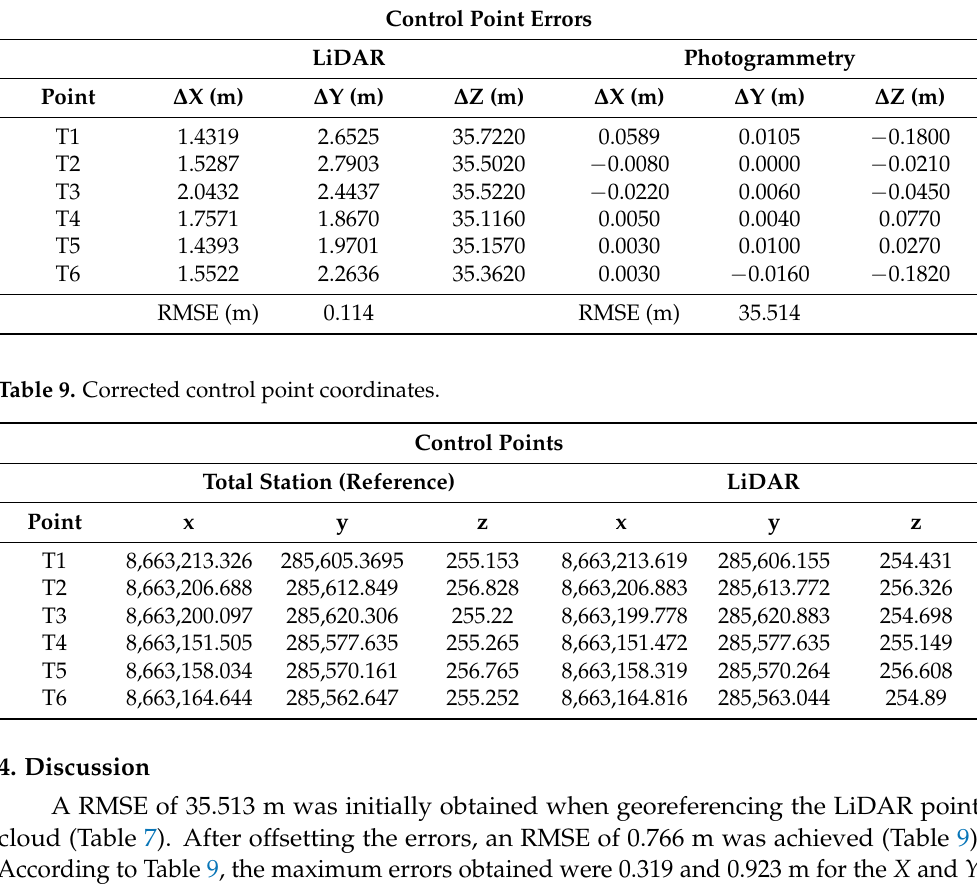
Table 8. Absolute error as a function of the difference in the control point coordinates between the methodologies applied, taking the total station survey as reference.